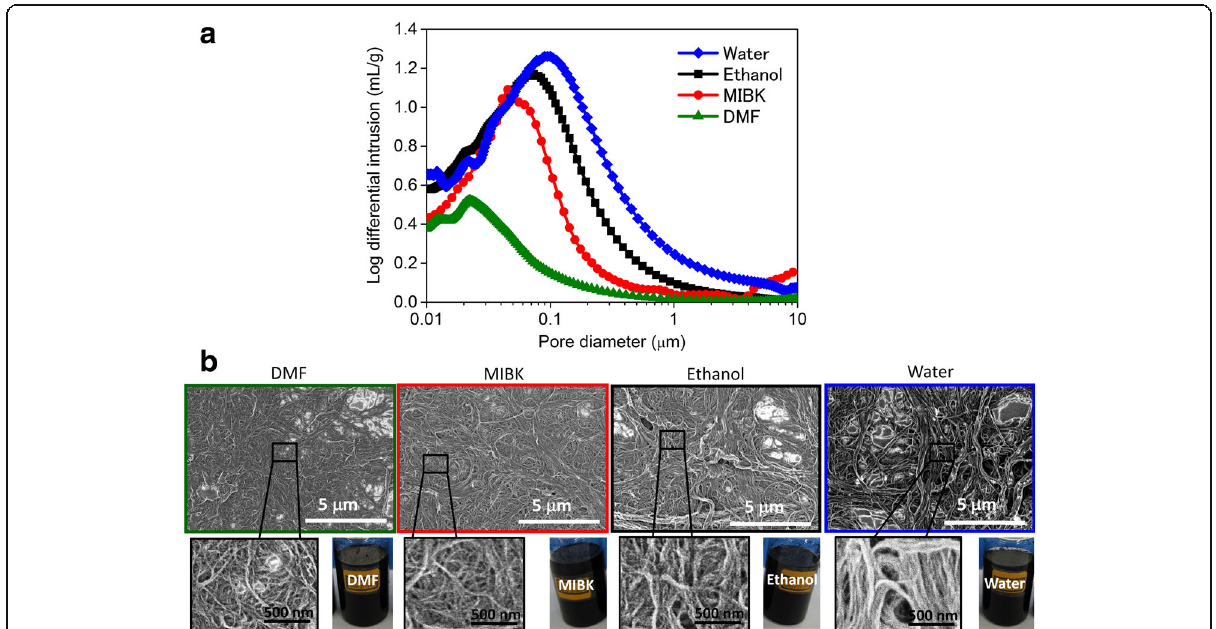
Fig. 3 Comparison of pores for SG SWNT Buckypapers made by different solvents. a Their pore volume distribution as a function of pore diameter, and b SEM images of the various SWNT bundle network structures spin-coated on flat surfaces, photographs of the dispersions, made using dimethyl- formamide (DMF), methyl isobutyl ketone (MIBK), ethanol and water, showing correlation between CNT dispersibility in solvent and the pore sizes of CNT